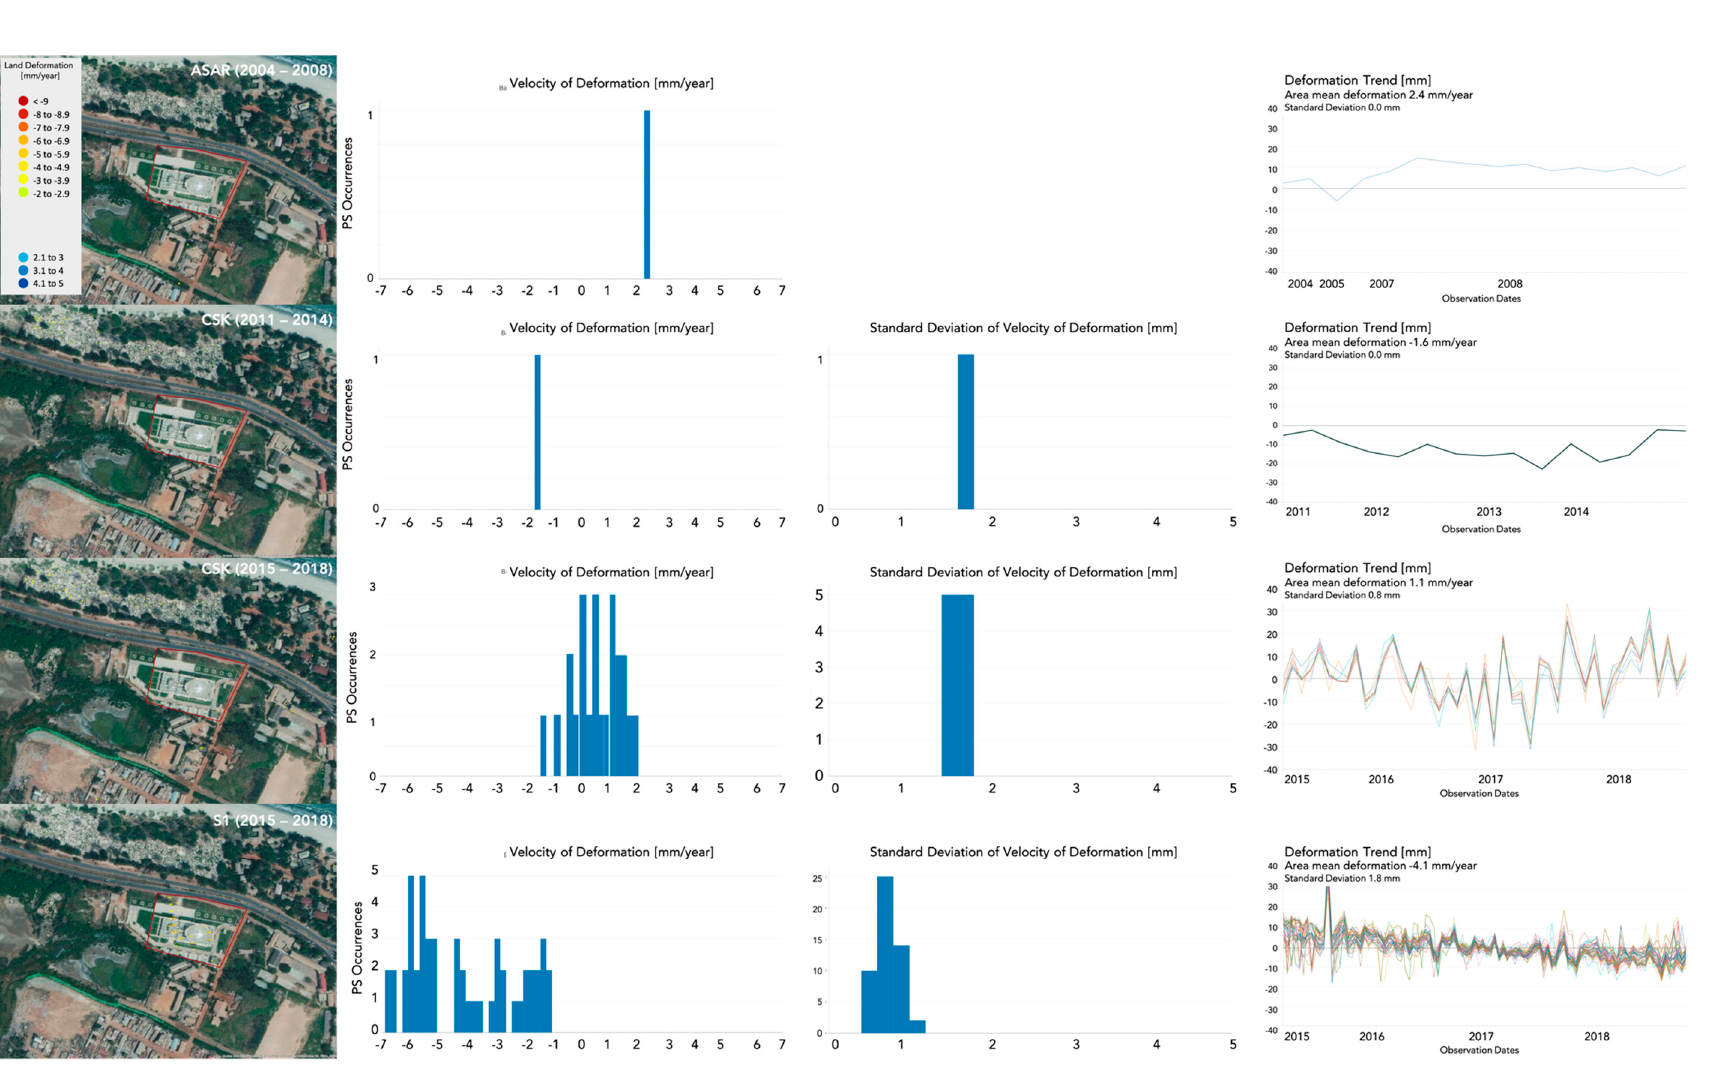
F igure 13. Banjul AOI 2. Figure 13. Banjul AOI